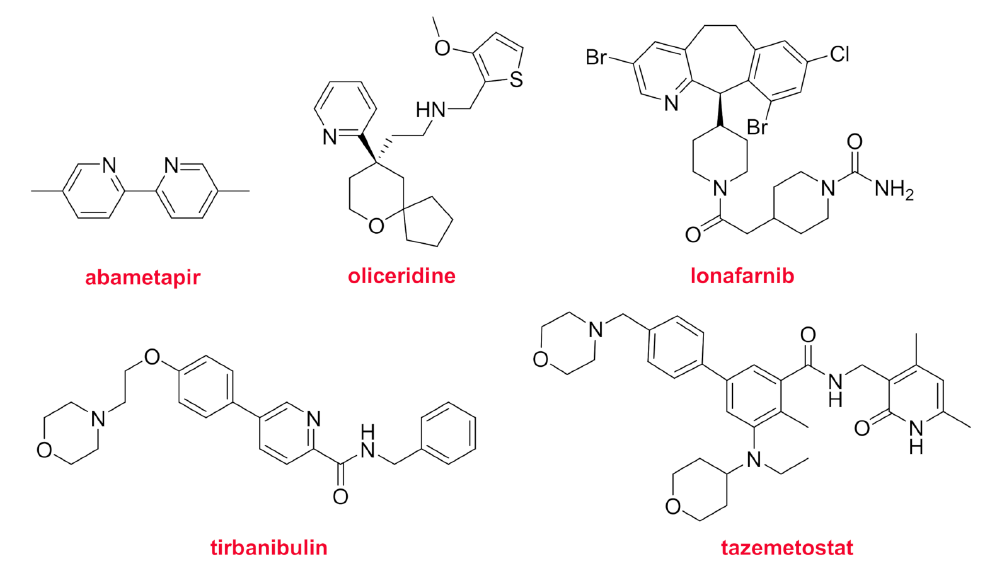
Figure 14. Structure of drugs containing pyridine